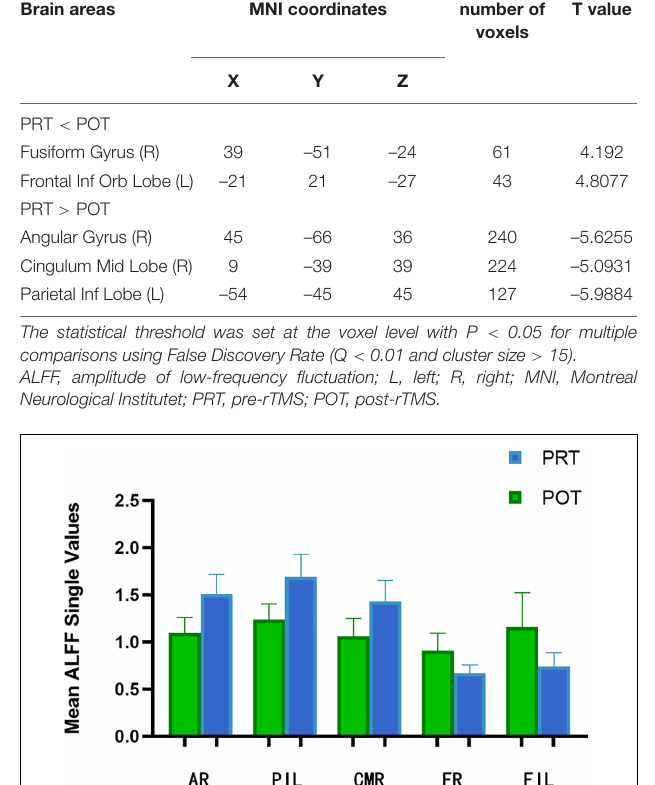
ALFF values of each brain region on an ROC curve. Brain regions with significantly different ALFF values showed high accuracy as diagnostic markers (PRT > POT).The AUCs of the ALFF values of the different brain regions were as follows: CMR (0.907,